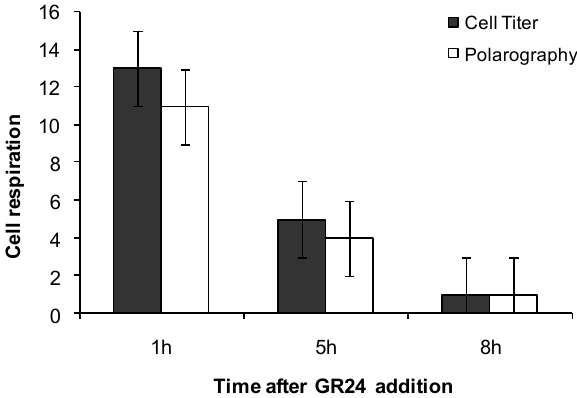
Figure 1. Cell respiration measured by using polarography method and CellTiterBlue reagent. Oxygen consumption was measured using polarographic method and CellTiter- Blue reagent. Values correspond to the ratio of slopes (100 × (s GR -s Ct )/s Ct ) obtained on cells elicited or not with GR24 during three independent